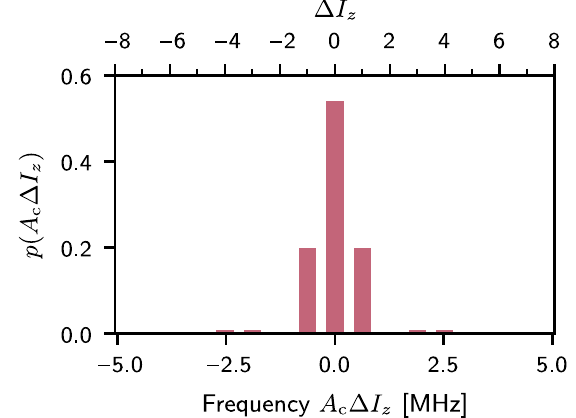
Δ I FIG. 15. Optimally purified state in the ideal case. p ð A z Þ c Δ I versus A z for the parameters found in Appendix E 6. With all c dephasing and damping rates set to zero, we model the ideal system under optimal purification, which occurs at Ω ¼ 29 MHz, T ¼ 86 ns, and τ 450 ns. The system is purified to a single max ¼ macrostate I z to within fluctuations of a single quantum, i.e., Δ I 1 . We plot only a small range of Δ I z ¼ (cid:3) z , since the total probability outside this range is negligible.